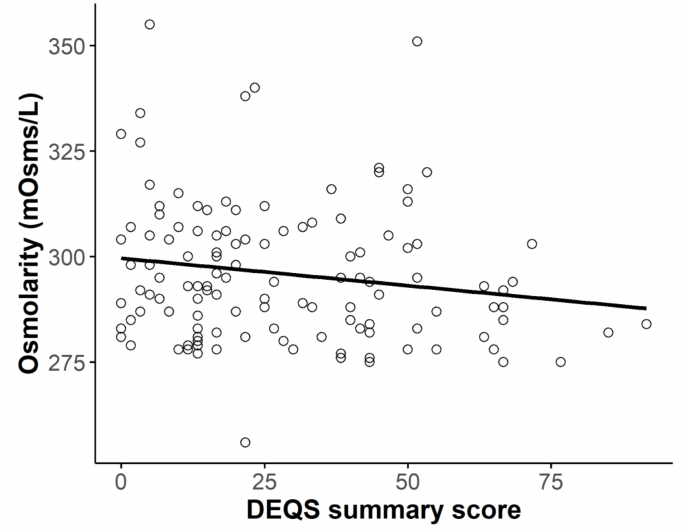
Figure 2. Relationship between total Dry Eye-Related Quality-of-Life Score (DEQS) and osmolarity. There was no correlation between total DEQS score and osmolarity ( r = − 0.168, p = 0.064, Pearson’s correlation